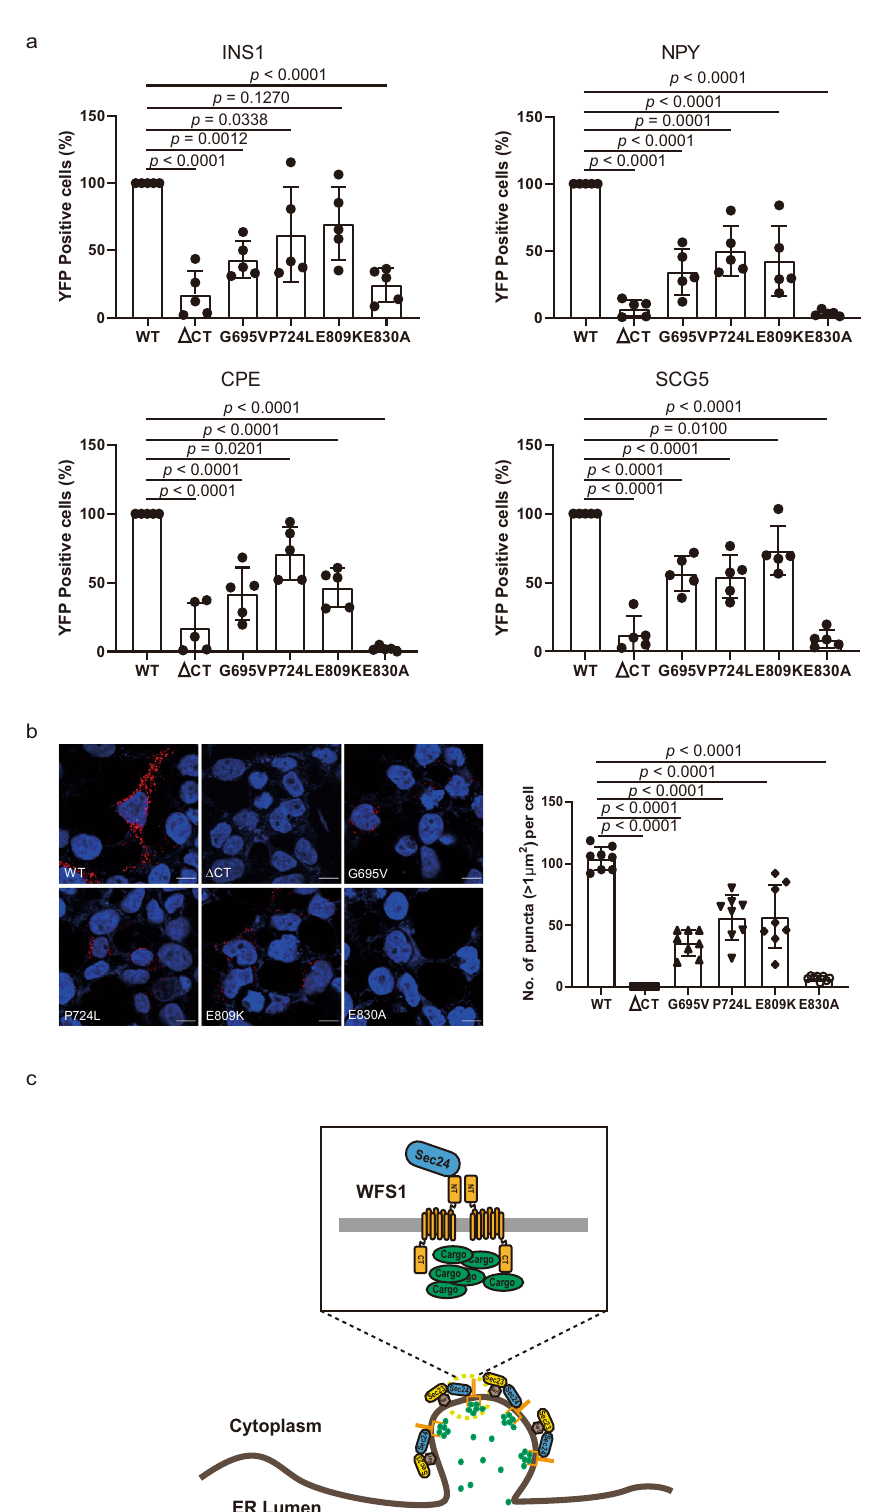
Fig. 7 WFS1 recognizes vesicular cargo proteins via its luminal C-terminal segment. a The interaction between different mutant WFS1 proteins and vesicular cargo proteins evaluated by BiFC and then quanti fi ed by fl ow cytometry. n = 5 independent experiments. b Representative imaging of the interaction between different mutant WFS1 and vesicular cargo protein SCG5 by PLA. The puncta number per cell was quanti fi ed by ImageJ software. n = 4 independent experiments, n = 8 independent images quanti fi ed. Scale bar, 10 μ m. c A model of WFS1 mediating vesicular cargo protein transport from the ER. All the data are presented as mean ± s.e.m. p < 0.05, signi fi cant, using a two-tailed Student ’ s t -test. Source data are provided as a Source Data fi